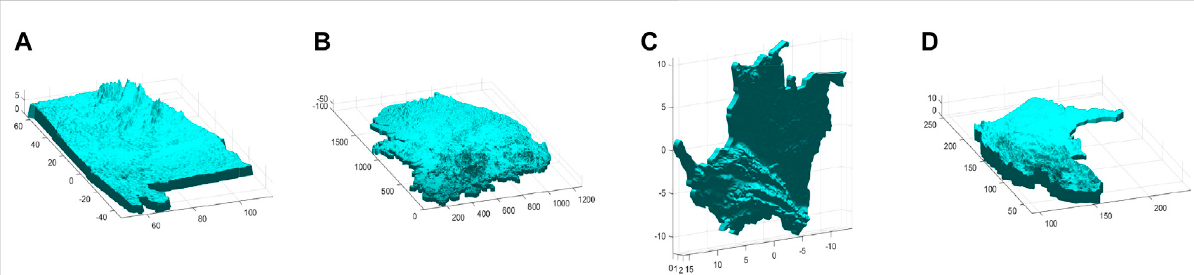
FIGURE 9 3Dmodels. (A) TopographicmapoftheUnitedStates. (B) TopographicmapofSouthKorea. (C) TopographicmapofColombia. (D) Topographic map of the capital of